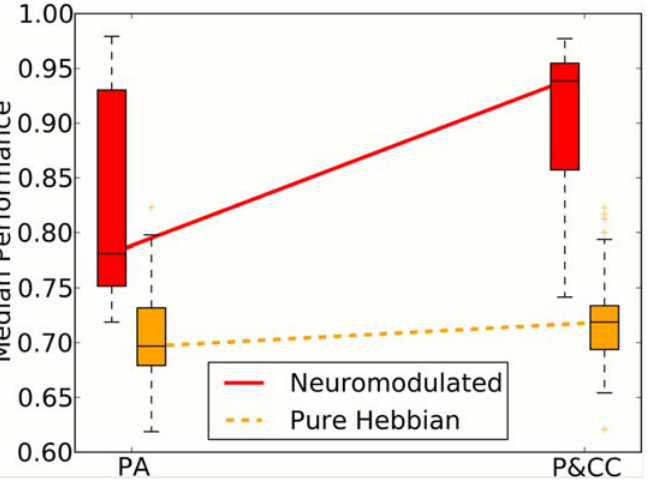
Fig 11. The effect of neuromodulation and connection costs when evolving solutions for catastrophic forgetting. Connection costs and neuromodulatory dynamics interact to evolve forgetting-resistant solutions. Without neuromodulation, neither treatment performs well, suggesting that neuromodulation is a prerequisite for solving these types of problems, a result that is consistent with previous research showing that neuromodulation is required to solve challenging learning tasks [25]. However, even in the non- neuromodulatory (pure Hebbian) experiments, P&CC is more modular (0.33 [95% CI: 0.33, 0.33] vs PA 0.26 [0.22, 0.31], p = 1.16 × 10 − 12 ) and performs significantly better (0.72 [95% CI: 0.71, 0.72] vs. PA 0.70 [0.69, 0.71], p = 0.003). That said, because both treatments perform poorly without neuromodulation, and because natural animal brains contain neuromodulated learning [28], it is most interesting to see the additional impact of modularity against the backdrop of neuromodulation. Against that backdrop, neural modularity improves performance to a much larger degree (P&CC 0.94 [0.92, 0.94] vs. PA 0.78 [0.78, 0.81], p = 8.08 × 10 − 6 ), in part by reducing catastrophic forgetting (see